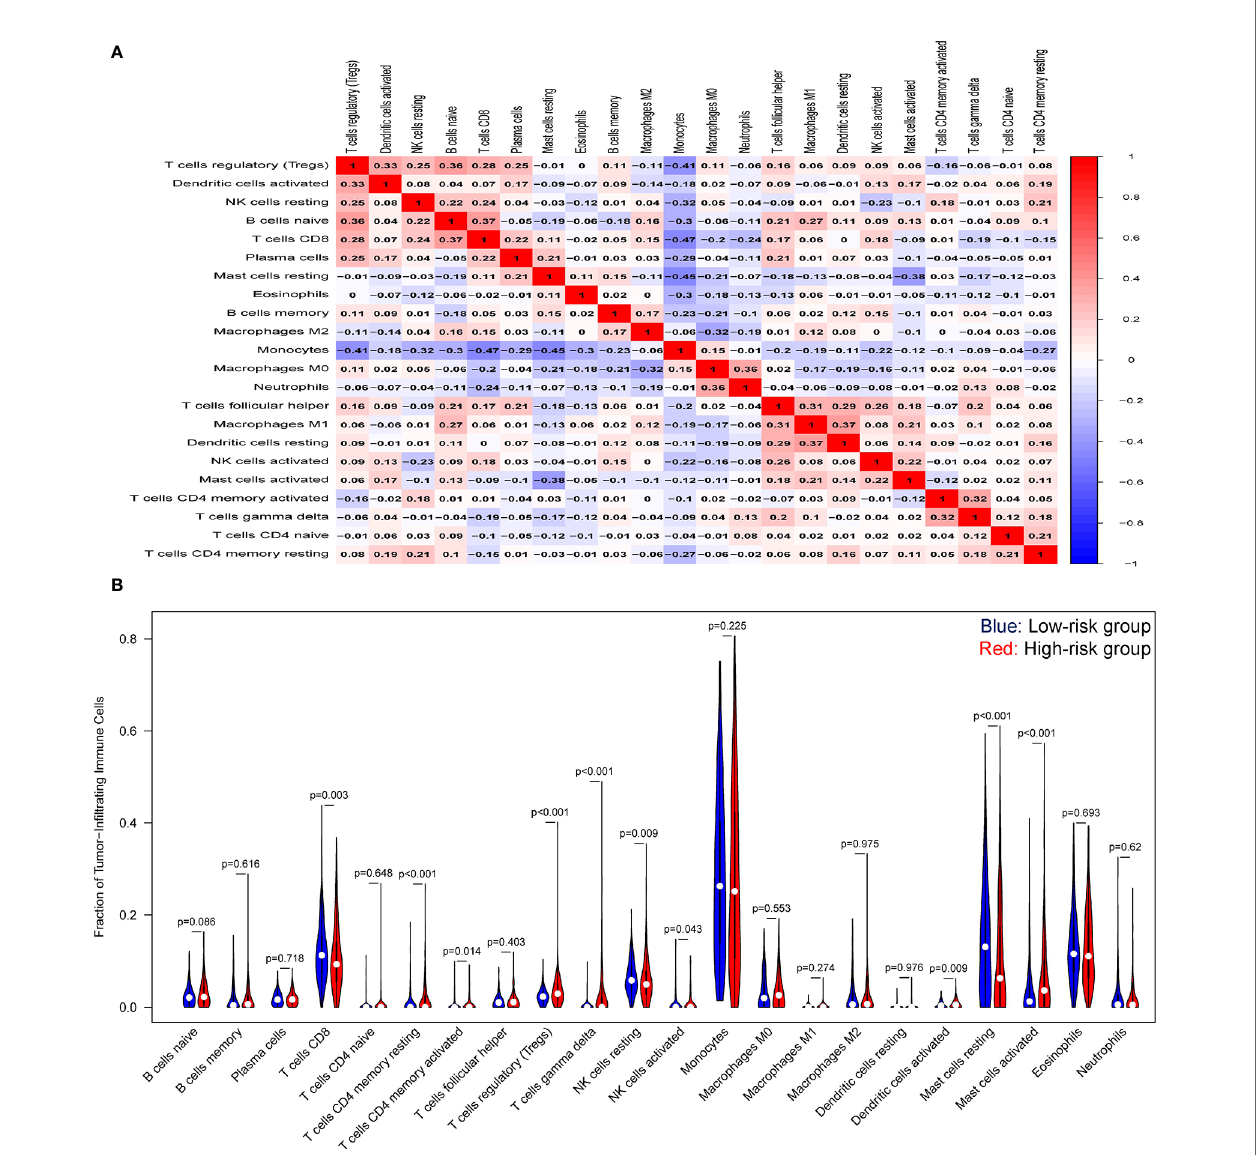
FIGURE 6 | Tumor-immune microenvironment analysis of the high- and low-risk groups. (A) Correlation heatmap of the ratio of tumor-in fi ltrating immune cells. (B) Difference between tumor-in fi ltrating immune cells. The blue violin re fl ects the low-risk group and the red violin represents the high-risk